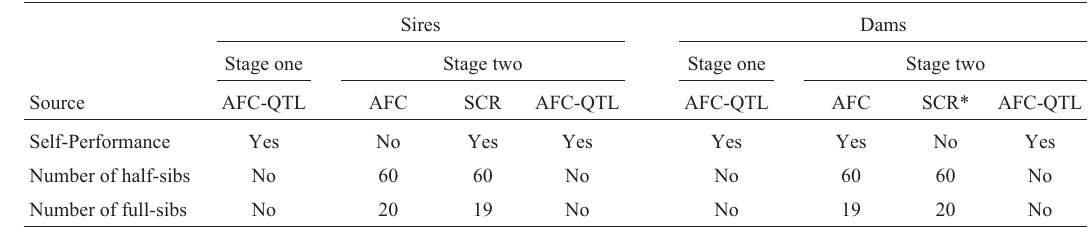
Table 1 - Age at first calving (AFC) quantitative trait loci (QTL), scrotal circumference (SCR) for sires and dams in the two different stages of each scheme.